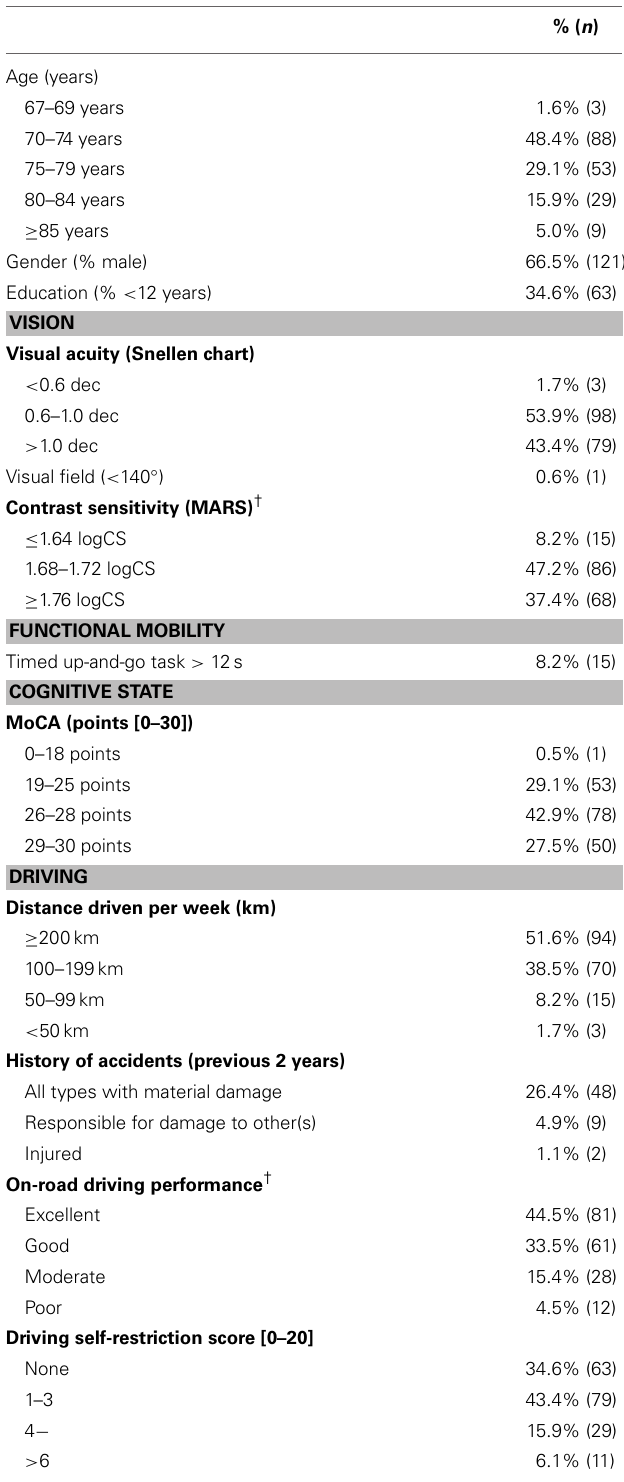
Table 2 | Characteristics of older home-dwelling drivers (Study 3: n =